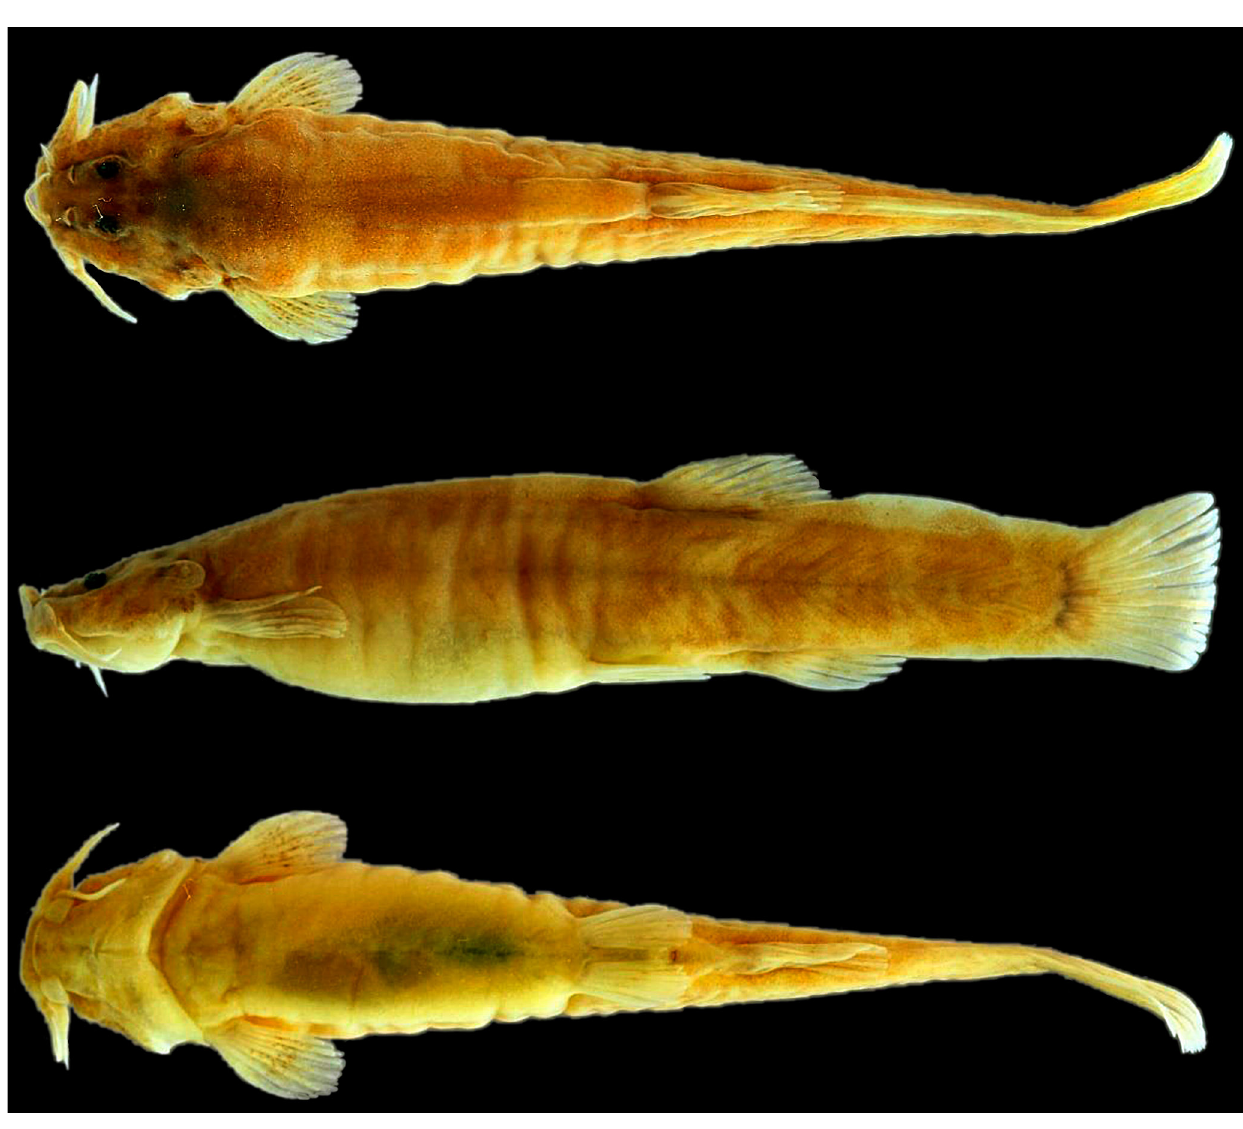
FIGURE 26 | Scleronema teiniagua , holotype (ZVC-P 14522; 45.2 mm SL) Uruguay, Artigas, arroyo Tres Cruzes, río Cuareím basin, lower río